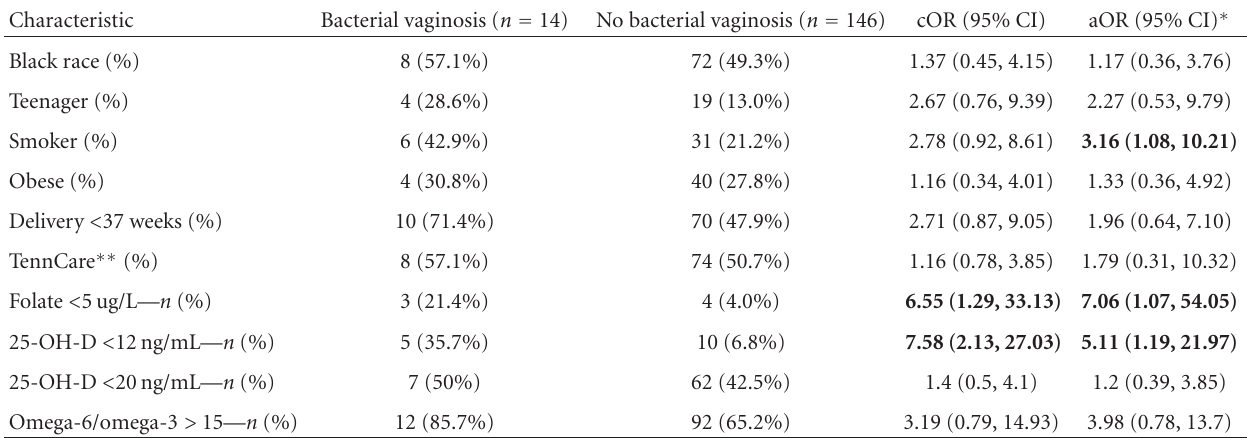
Table 2: Crude and adjusted odds for bacterial vaginosis during pregnancy according to maternal characteristics.